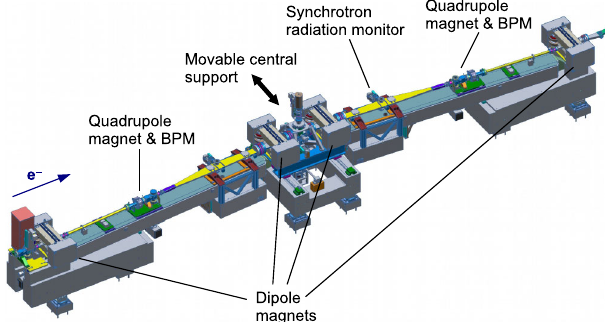
FIG. 27. 3D drawing of the bunch compression chicane showing the initial configuration featuring dipole magnets with